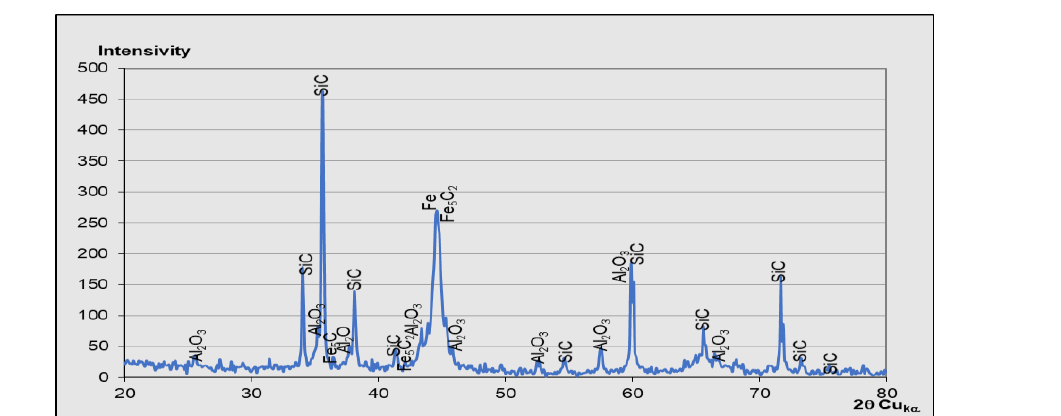
Fig. 3. X-ray diagram of powder SIAL-M32